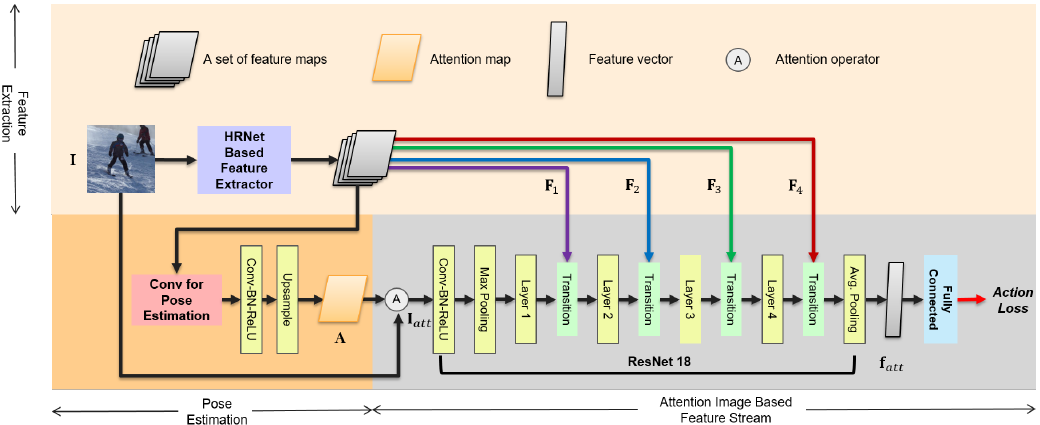
Figure 3. Attention-image-based feature stream. The figure depicts the shared feature extractor, pose estimation, and attention-image-based feature stream depicted in Figure 1. The background colors are the same as Figure